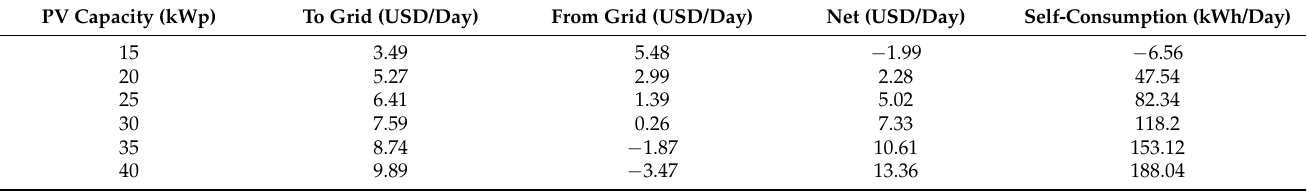
Table 7. Daily energy cost and self-consumption for different PV capacities (WT = 4.5 kW).